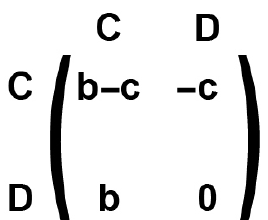
Figure 1. The payoff matrix that is used to implement the prisoner’s dilemma. The choice each player makes during an interaction with each other will affect the payoff received. Here, b represents the benefits distributed by a cooperator, whilst c represents the cost that the act of cooperating will incur. Parameters should be configured to adhere to the condition of b > c > 0. In the simulations we use b = 10 and c =